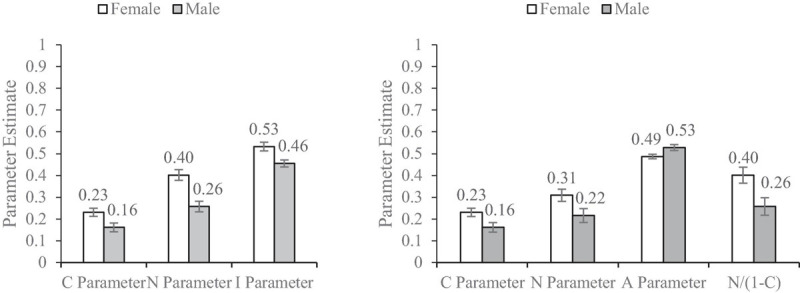
Results of Study 1b by Gawronski et al. (2017) obtained from the CNI model (left) and CAN algorithm (right). Error bars represent ± 1 SE.